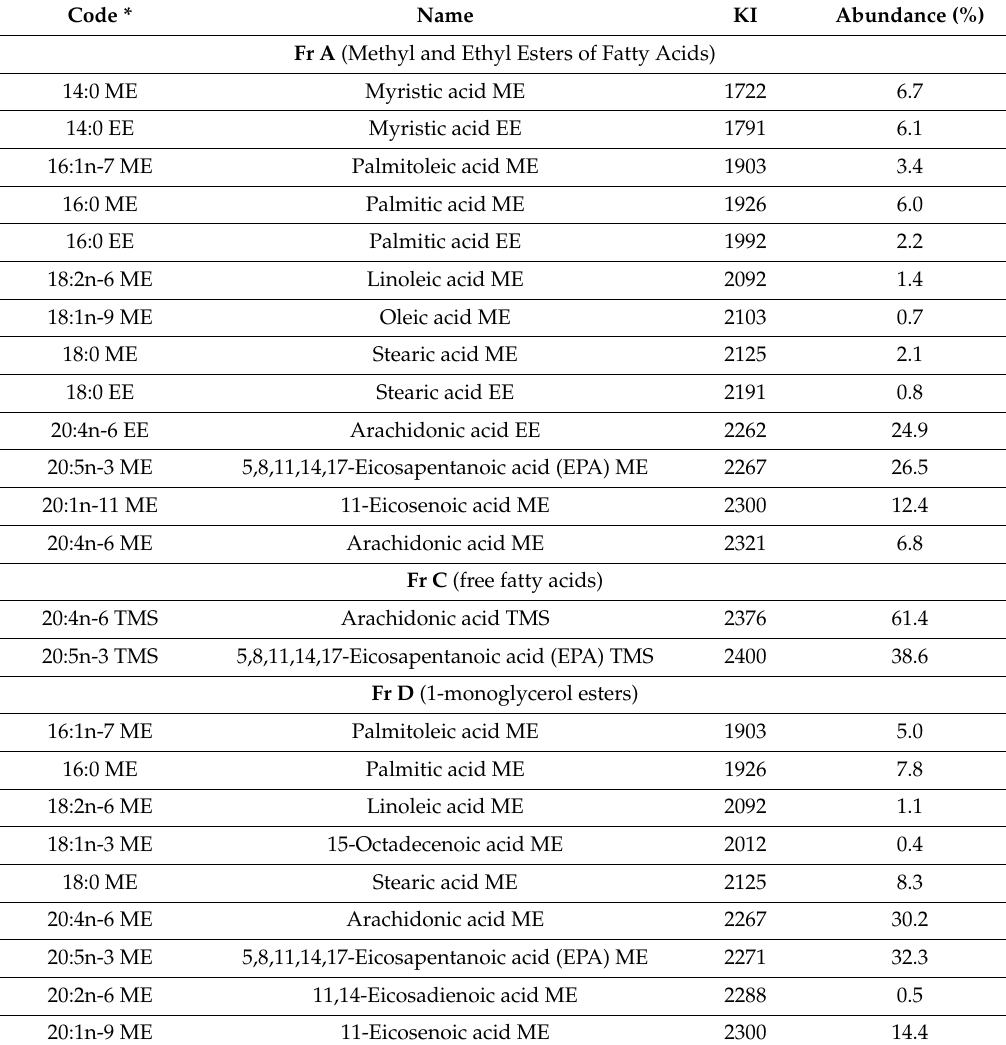
Table 1. Fatty acid profile of chromatographic fractions (frs) from the crude extract of Paracentrotus lividus